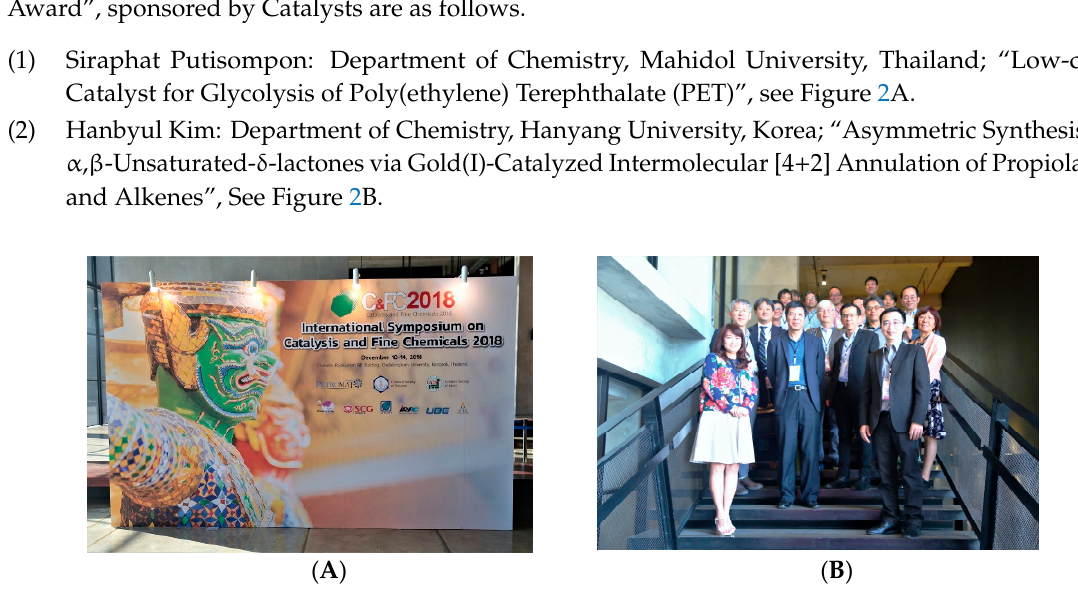
Figure 1. Announcement of the symposium at the entrance ( A ) and international advisory board, C&FC2018 ( B ).